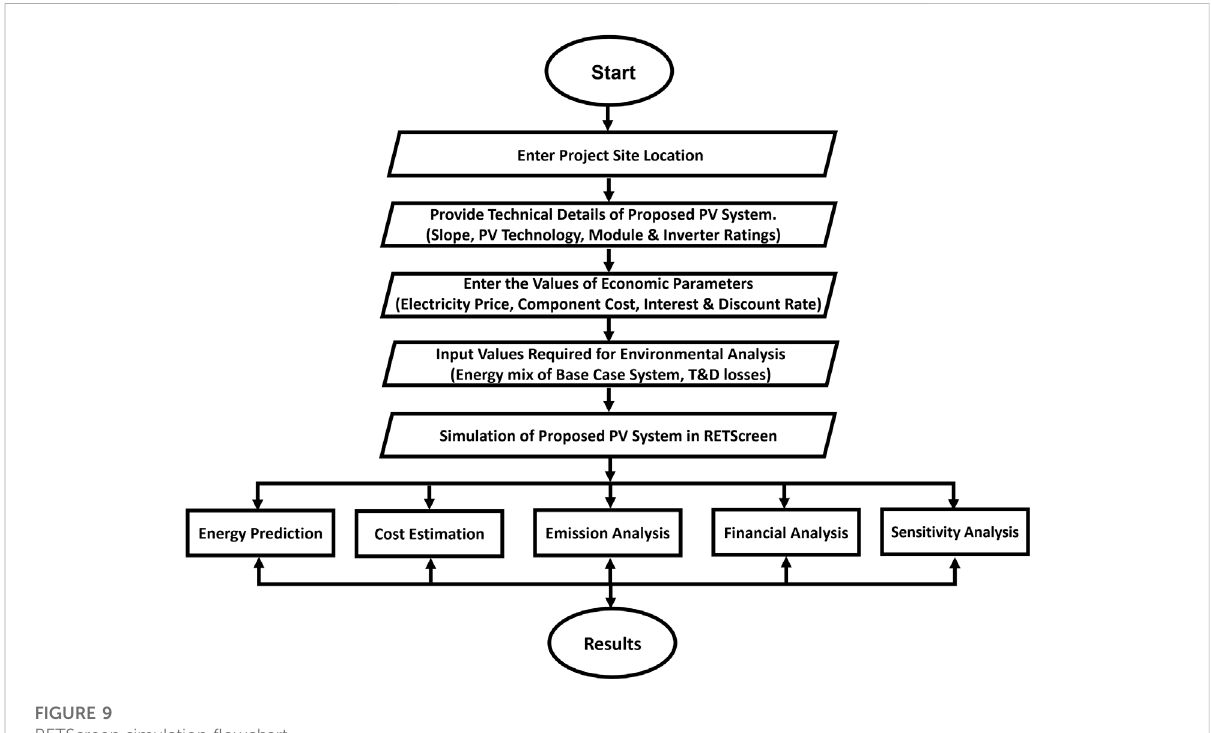
FIGURE 9 RETScreen simulation fl